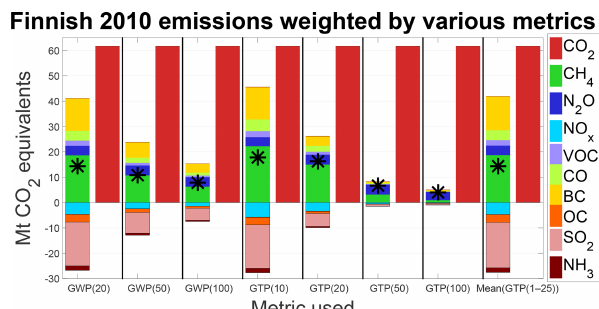
Figure 2. Finnish 2010 emission (MtCO 2 equivalents) as a pulse emission weighted by various global metrics. CO 2 is separated out and the net impact of the non-CO 2 is given by the